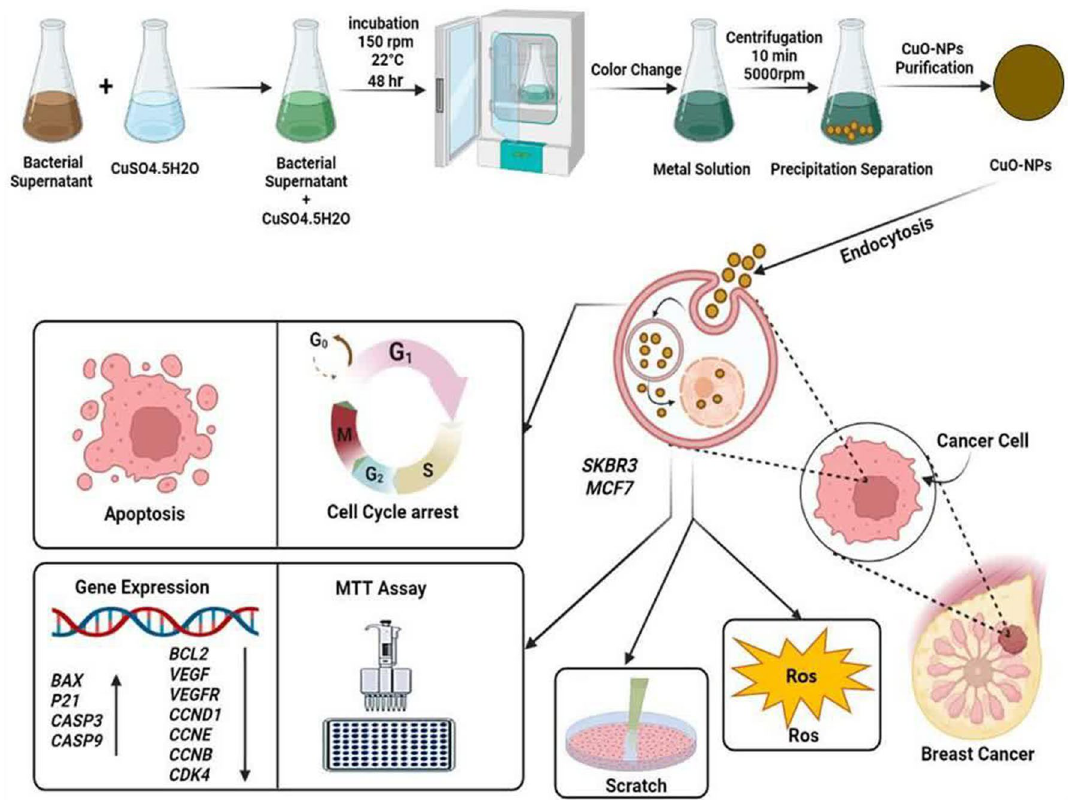
Figure 14. Biogenic synthesis of CuONPs using Bacillus coagulans , cellular uptake, ROS generation, apoptosis induction, and cell cycle arrest in breast cancer